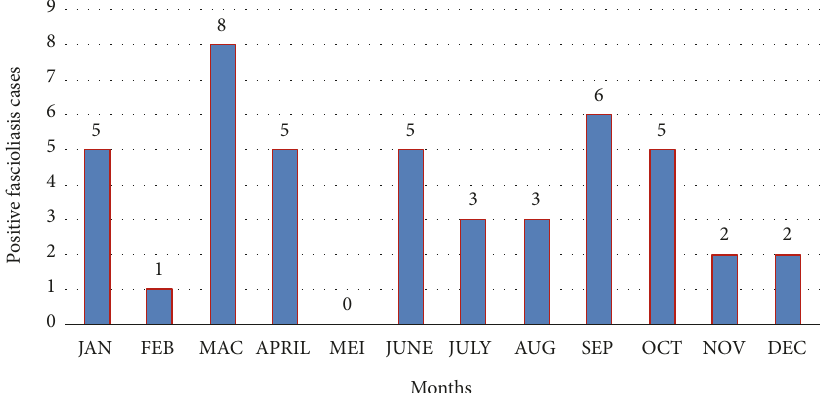
Figure 3: Monthly trends of fascioliasis cases in five Regional Veterinary Laboratories in Peninsular